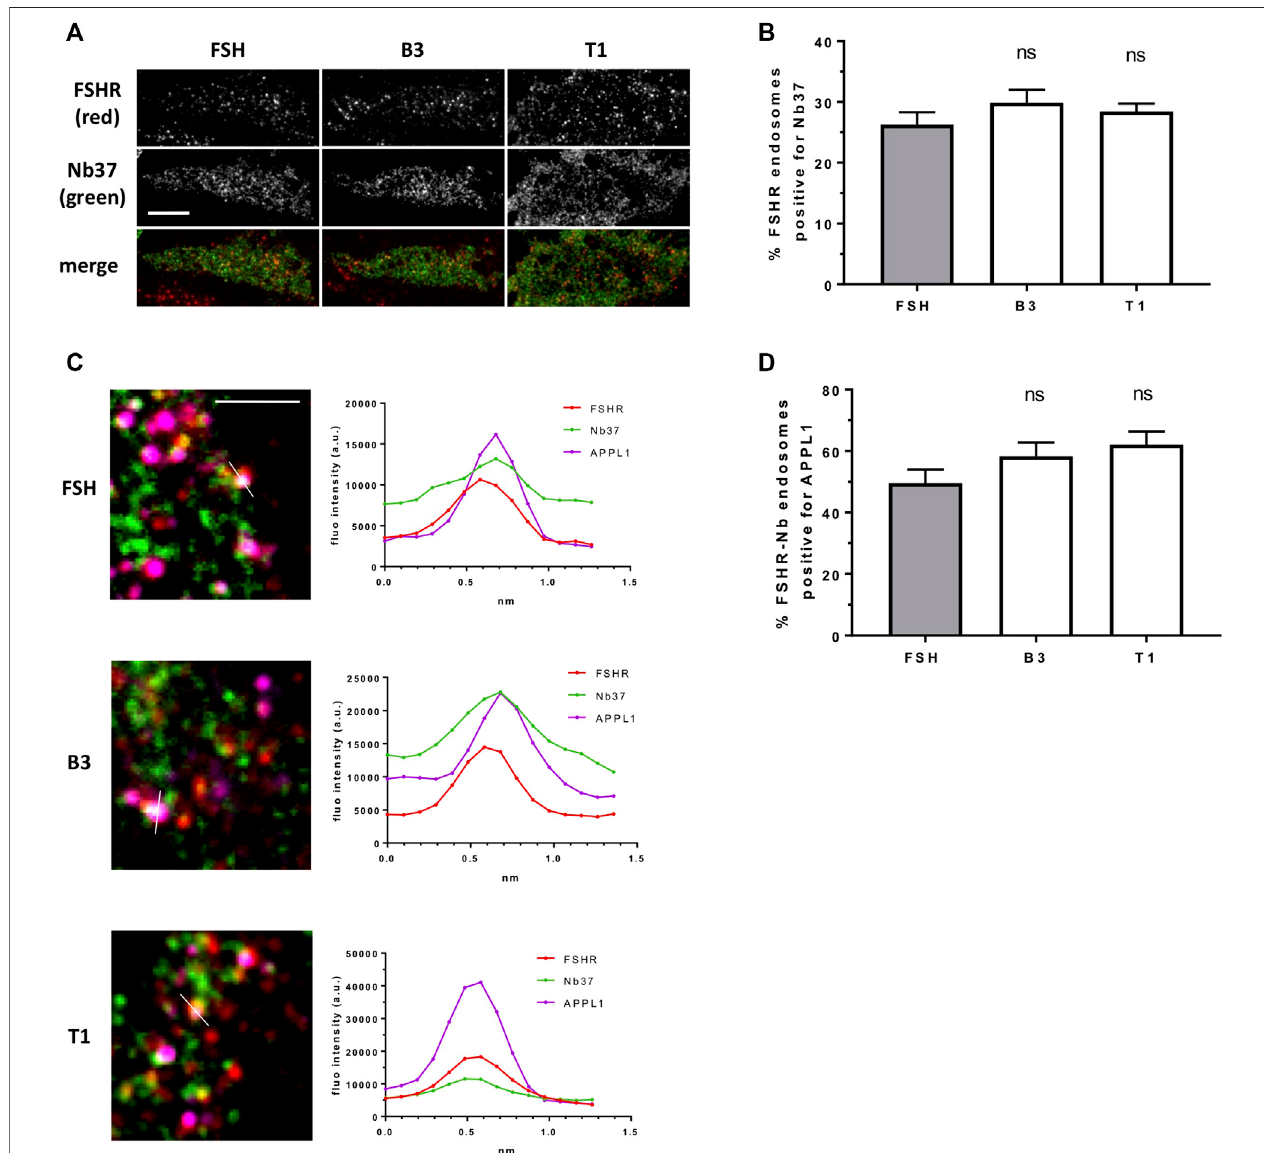
FIGURE5| LMWcompoundsinduceG α sactivationfromFSHRendosomes. (A) TIR-FMimagesofFLAG-FSHR(red)expressingcellstransfectedwithNb37-GFP (green) treated with either FSH (10 nM), B3 or T1 (10 μ M) for 5 min. Scale bar (cid:2) 10 μ m. (B) Quanti fi cation of FSHR endosomes from (A) ; n (cid:2) 24 cells/condition in three independentexperiments. (C) TIR-FMimages(top)ofFLAG-FSHR(red),Nb37-GFP(green)andendogenousAPPL1(magenta)incellsstimulatedwitheitherFSH,B3or T1 for 5 min. Scale bar (cid:2) 3 μ m. Line scan analysis of fl uorescence intensity (bottom) is shown for one endosome per condition showing FSHR-Nb37-APPL1 colocalization (representative of 233, 302, 316 endosomes for FSH, B1, T3, respectively). (D) Quanti fi cation of FSHR-Nb37 endosomes positive for APPL1 after 5-min stimulation with either FSH, B3 or T1; n (cid:2) 11 – 12 cells/condition from (C) from three independent experiments.